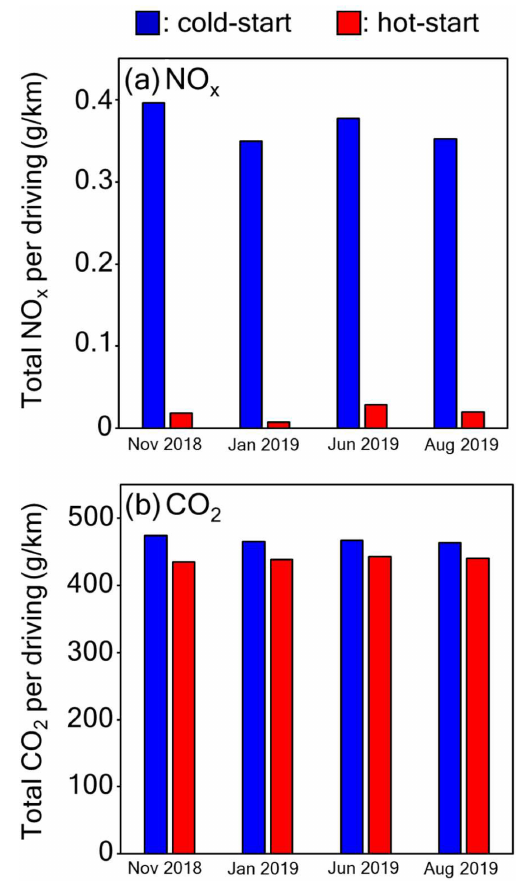
Figure 3. Experimental results of chassis dynamometer tests for world harmonized vehicle cycle cold and hot starts for (a) NO x and (b) CO 2